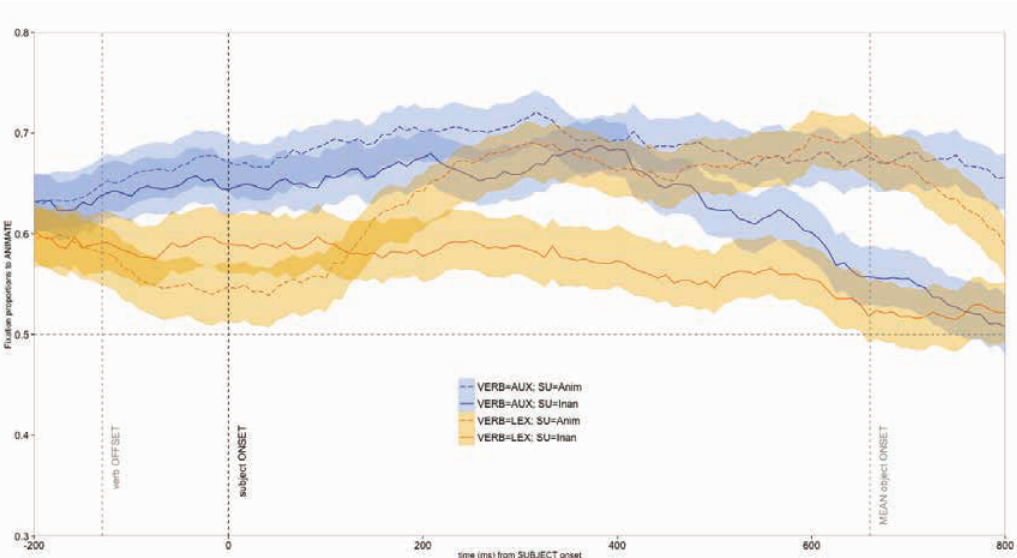
Figure 3: Gaze plot of animate fixation proportions in each condition time-locked to subject onset. The lines indicate mean fixation proportions and the transparent bands indicate 1 SE above/below the means. Blue lines indicate conditions with an auxiliary finite verb, orange lines indicate conditions with a lexical finite verb, dashed lines indicate conditions with an animate subject, and straight lines indicate conditions with an inanimate subject.